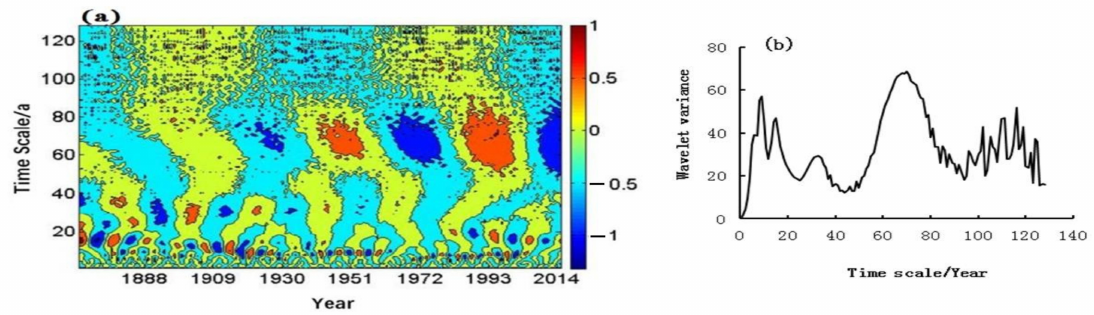
Figure 9. Wavelet analysis of ENSO. ( a ): wavelet real part of ENSO; ( b ): wavelet variance of